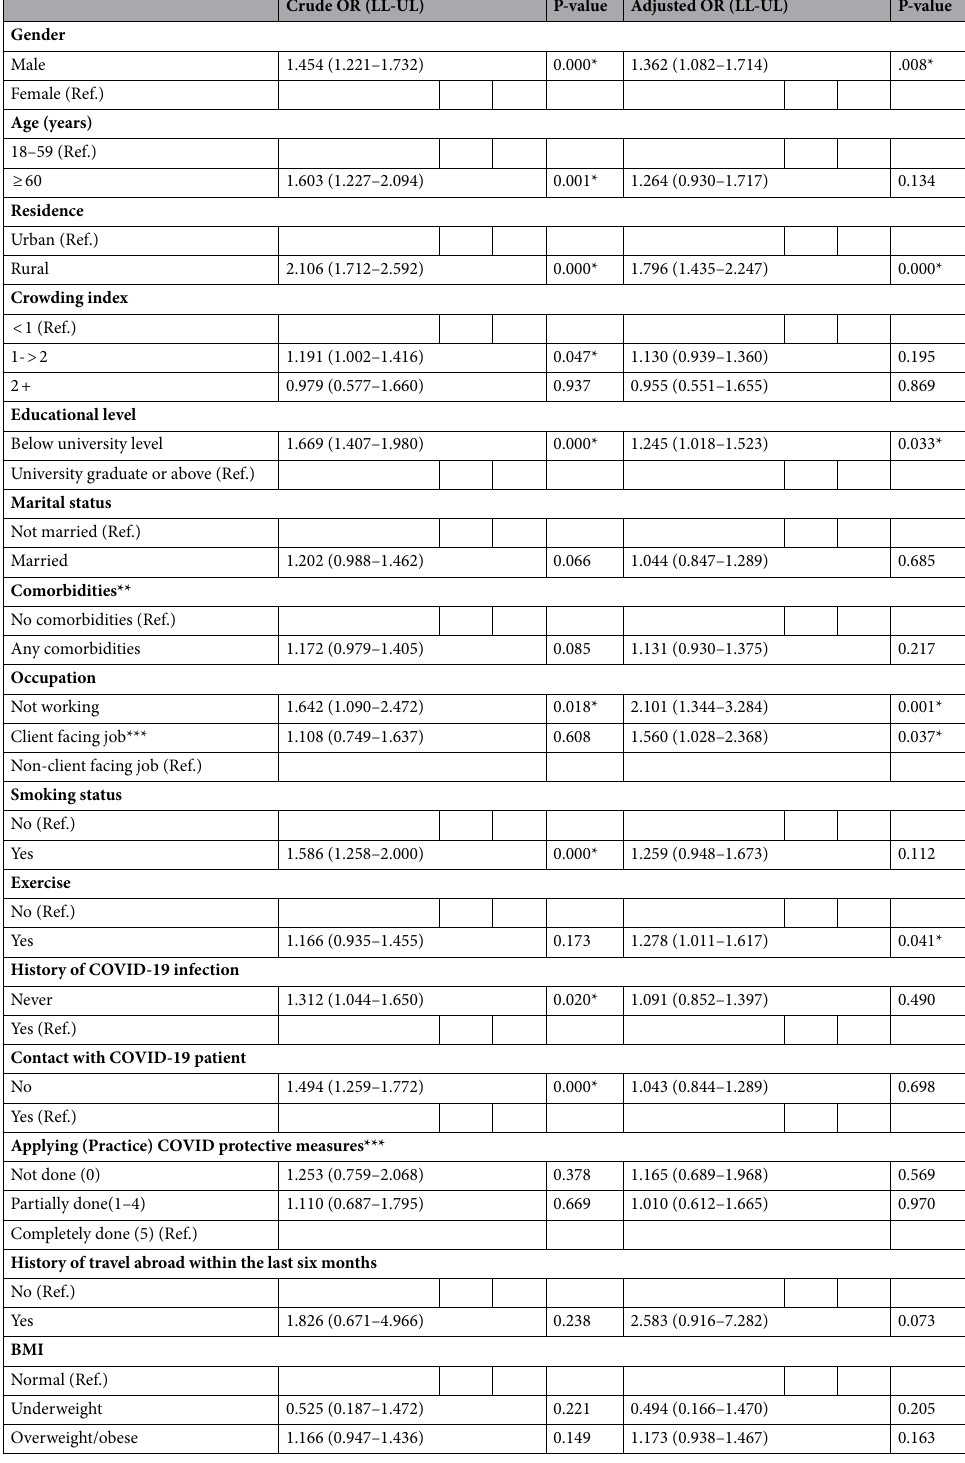
Table 3. Predictors of vaccine acceptance among adult Egyptian participants (n = 2352). **Chronic morbidities include cardiac diseases, hypertension, diabetes mellitus, chronic renal and liver